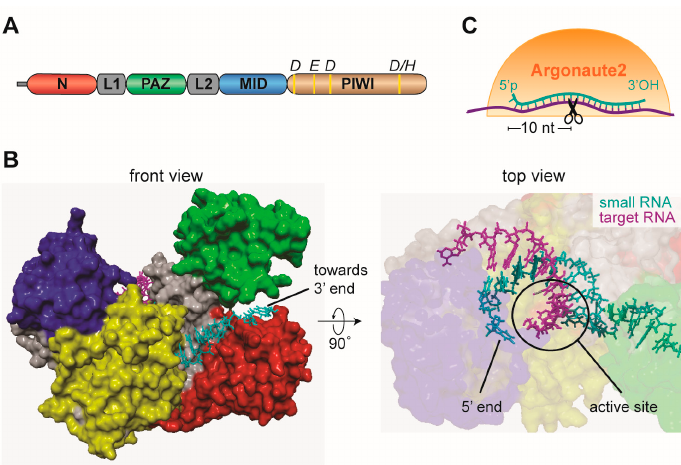
Figure 3. Argonaute proteins are at the core of small RNA silencing pathways. ( A ) Schematic representation of the domain organization of mammalian Argonaute and the conserved residues required for slicer activity. ( B ) Crystal structure of human AGO2 in association with a guide RNA and a target RNA base pairing from nucleotide 2 to 8. Protein domains are colored in accordance to the scheme in A. The structure was determined by Schirle and colleagues [49] and the published PDB file (4W5Q) was edited in Yasara View. ( C ) Schematic representation of target slicing by Argonaute proteins.